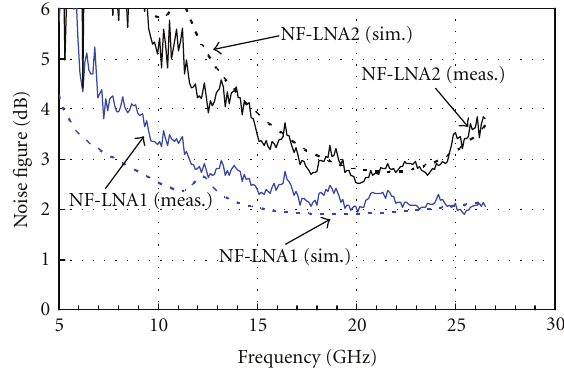
Figure 6: Measured and simulated NF of the dual-LNA MMIC with subcircuits LNA1 and LNA2 designed for low NF and high linearity, respectively.